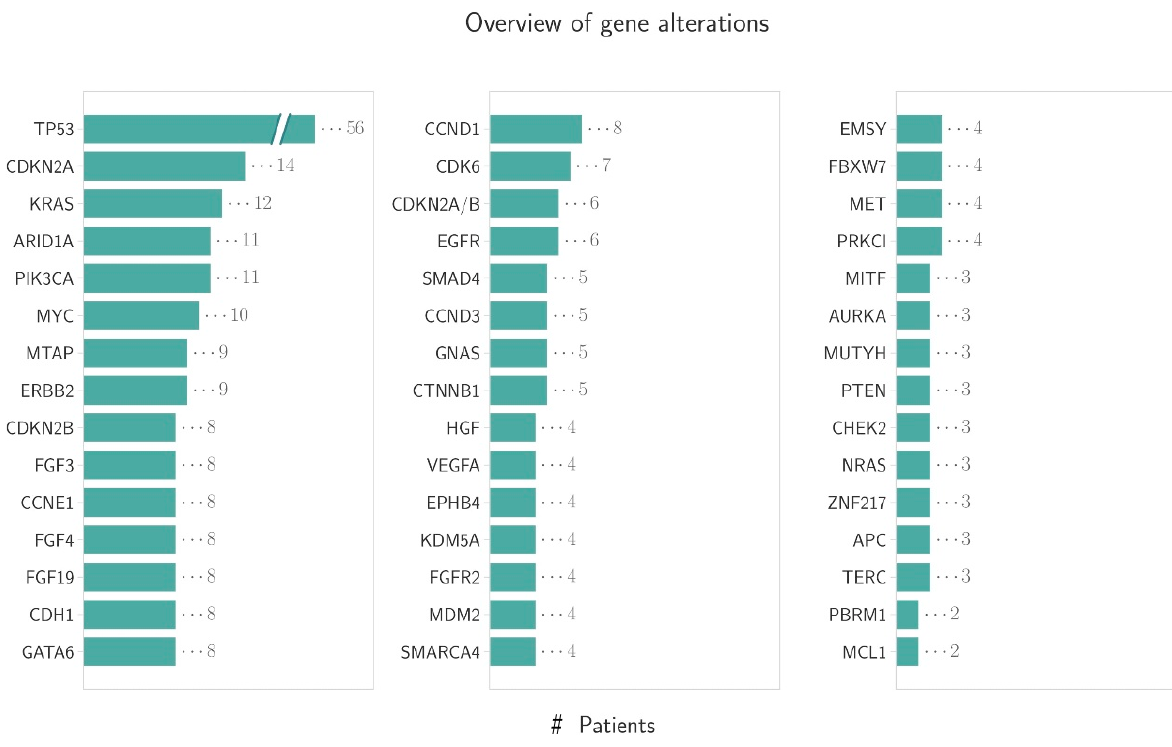
Figure 6. All detected gene alterations (# indicates number of patients). The most frequently altered oncogenic signaling pathway in our cohort was RTK/RAS (37.5%), followed by PI3K/mTOR/AKT (19.4%). The results of the pathway analysis are shown in Figure 7.